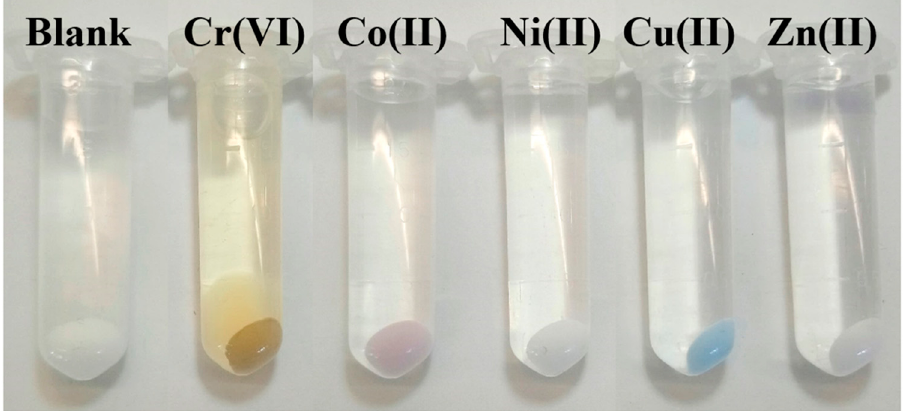
Figure 3. Photograph of the JNP-bPEI 2 mL after absorption of Cr (VI), Co(II), Ni(II), Cu(II), Zn(II) and centrifugation.